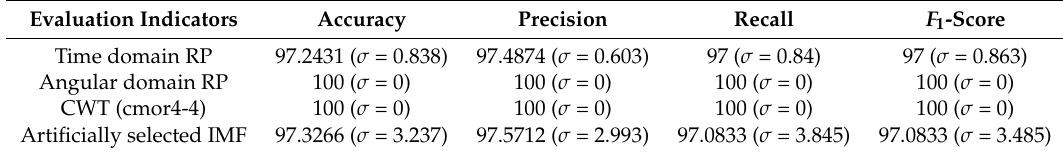
Table 2. Performance results of different methods executed 10